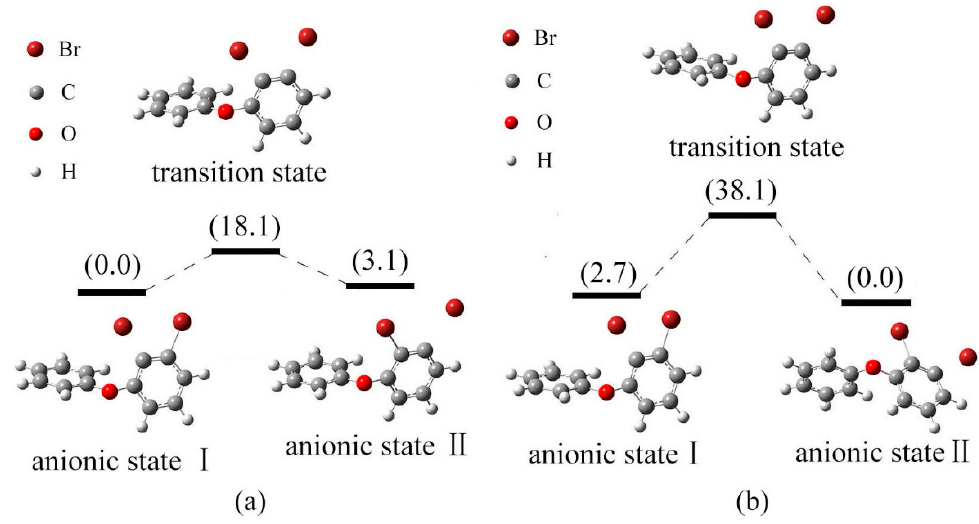
Figure 8. Relative energy of three possible anionic states and the transition states between them for BDE-5 (kJ/mol). (( a ) in gas phase; ( b ) in solution).